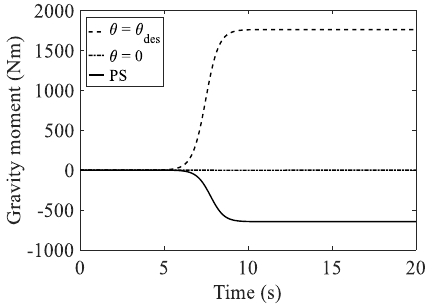
Figure 5. Time-domain response of the gravity moment of the vehicle.